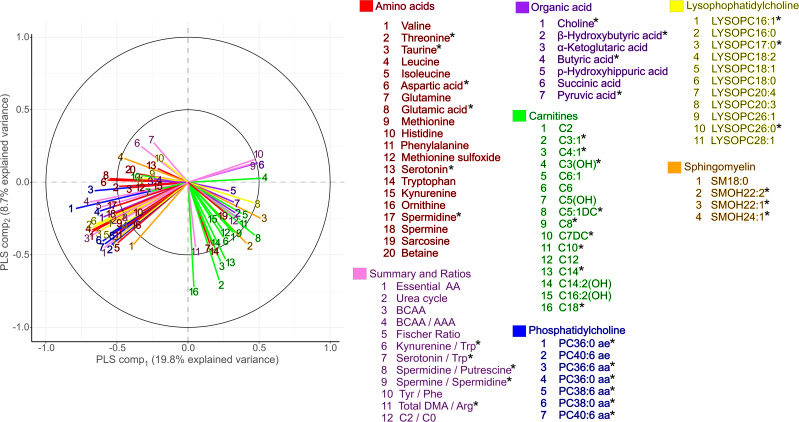
Correlation plot of the 77 retained metabolite variables in serum that best distinguish SAM survivors (n = 122) from community participants(n = 90) based on sPLS-DA.Asterisks indicate metabolite variables that also have both an FDR-corrected P < 0.05 and an absolute log2 fold change > 0.25 in univariate models. AA, amino acids; FC, fold change.